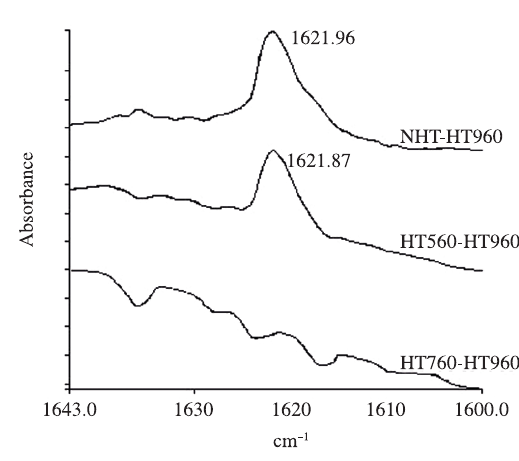
Figure 5. Reappearance of O-H stretching vibrations bands, with the increase of pyridine desorption temperature of zeolite sample NHT. a) Silanols (Si-OH) groups. b) Bridged Si-OH-Al